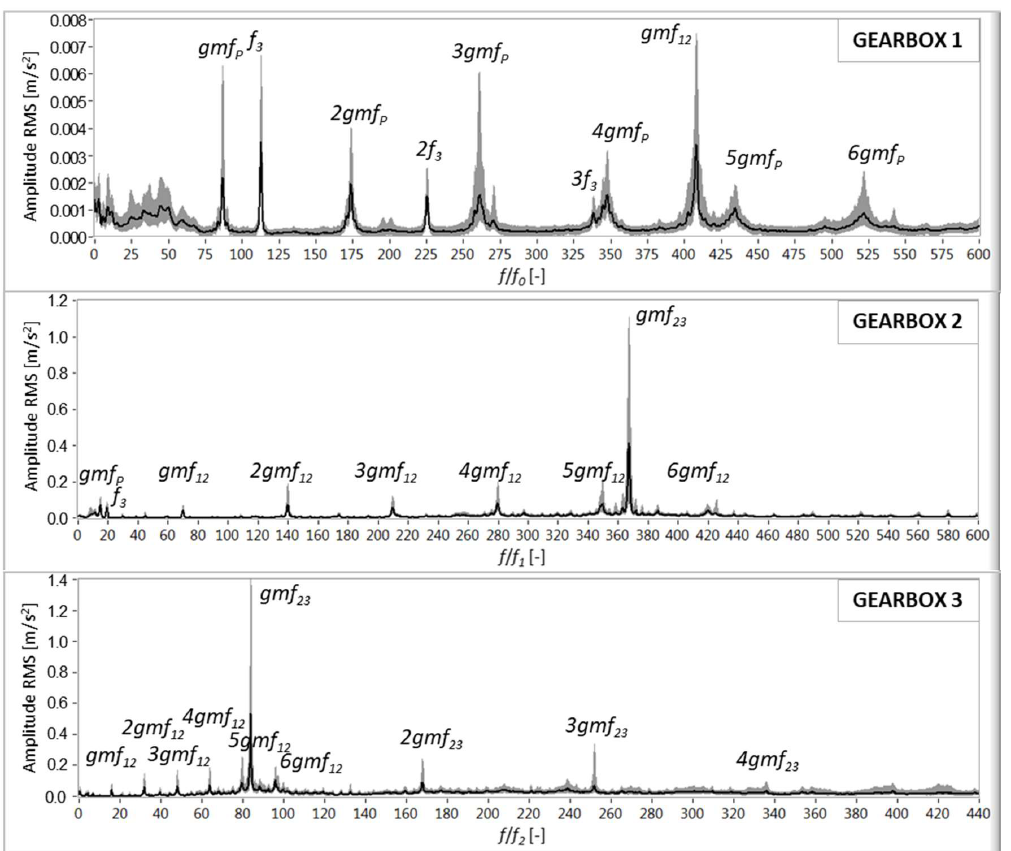
Figure 6. Median spectrum (black line) and amplitude levels between 25th and 75th percentiles (grey region) of the vibrations measured on the gearbox.